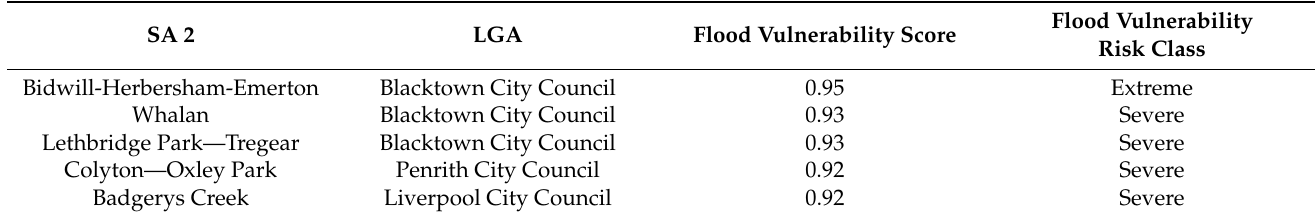
Table A1. Summary of the most vulnerable communities within the Hawkesbury-Nepean catchment by statistical area